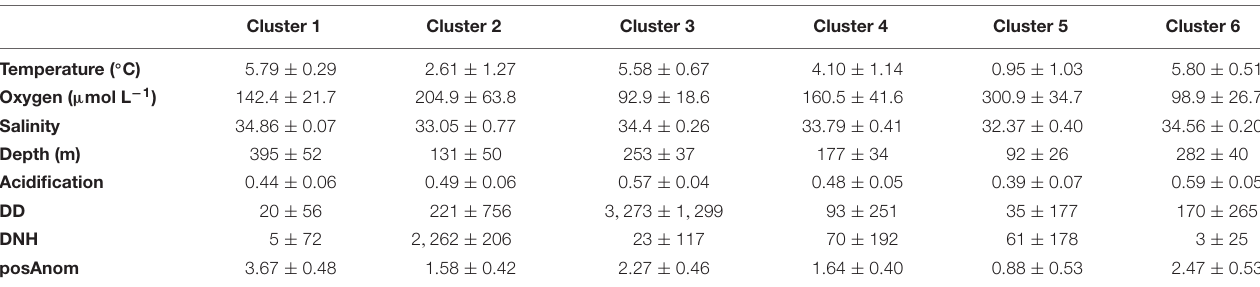
FIGURE 3 | Location of the six habitats in the Estuary and Gulf of St. Lawrence identified by k-means clustering with environmental data ranging from 2011 to 2018. Deep channels are shown in blue (depth > 200 m). TABLE 2 | Summary of environmental clusters environmental values (mean ±